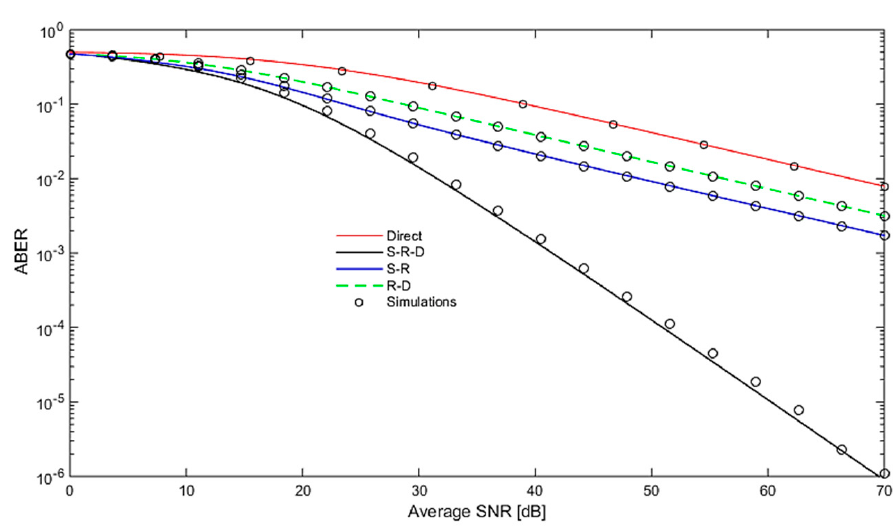
Figure 15. ABER vs. SNR of FSO over the G ‐ G channel for strong turbulence with distance 600–400 m, the number of relays = 3, and w z = 0.5 m.